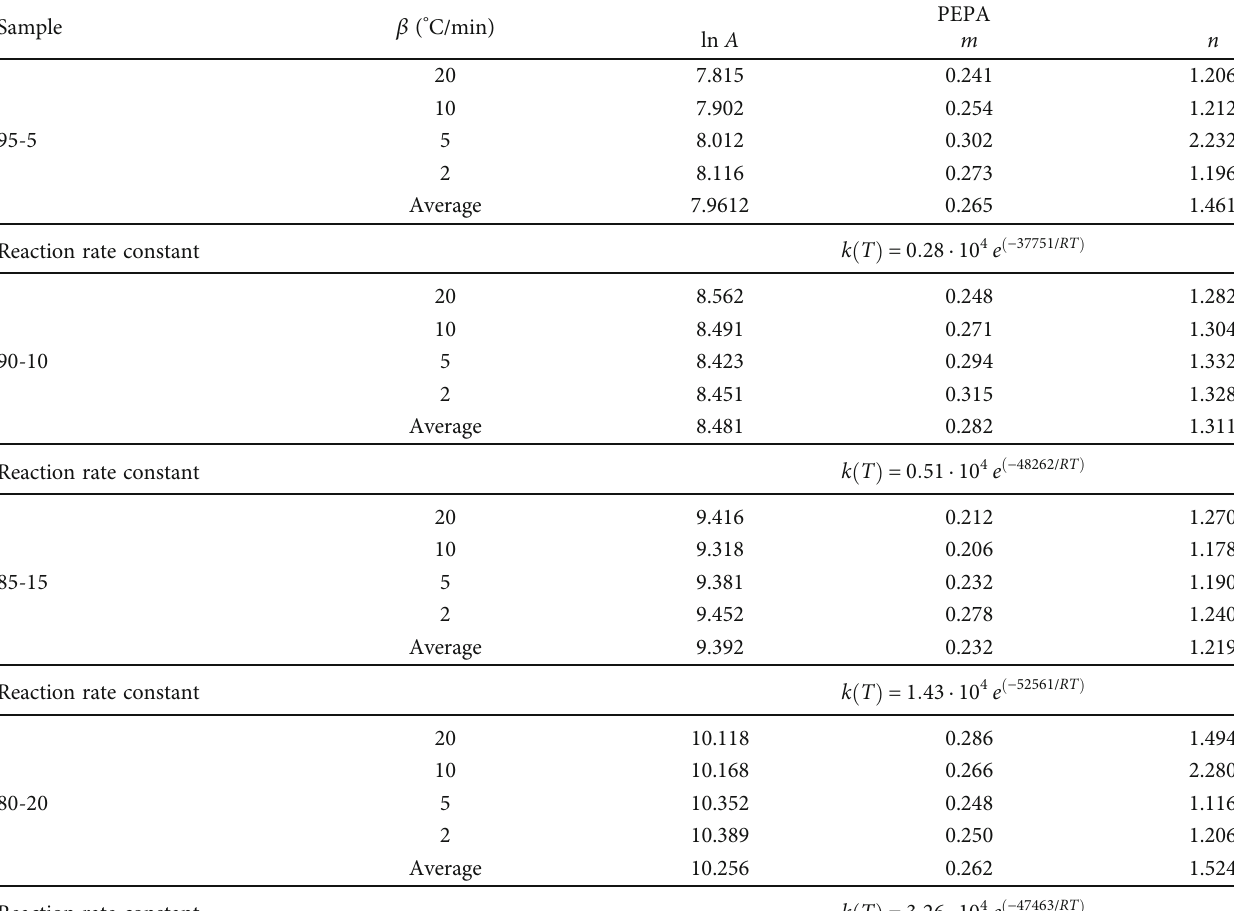
Table 4: Kinetic parameters.